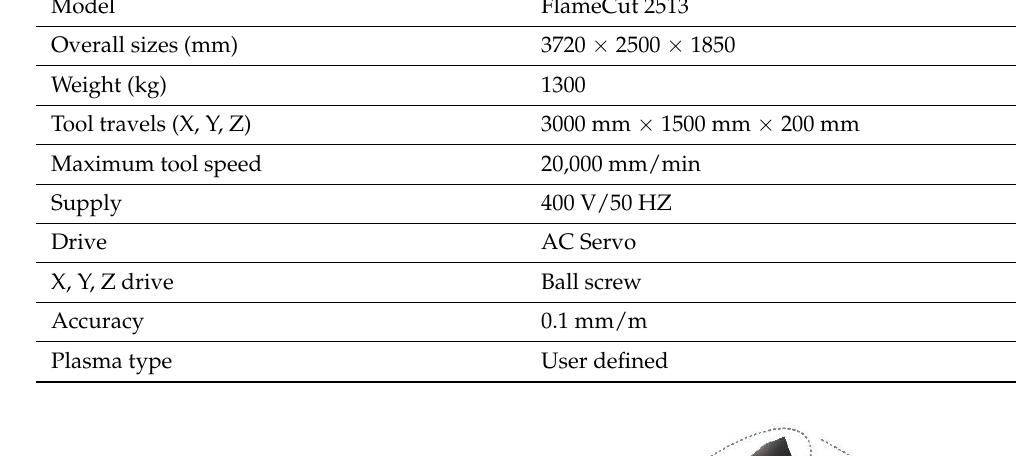
Table 2. Specifications of CNC machine FlameCut 2513.